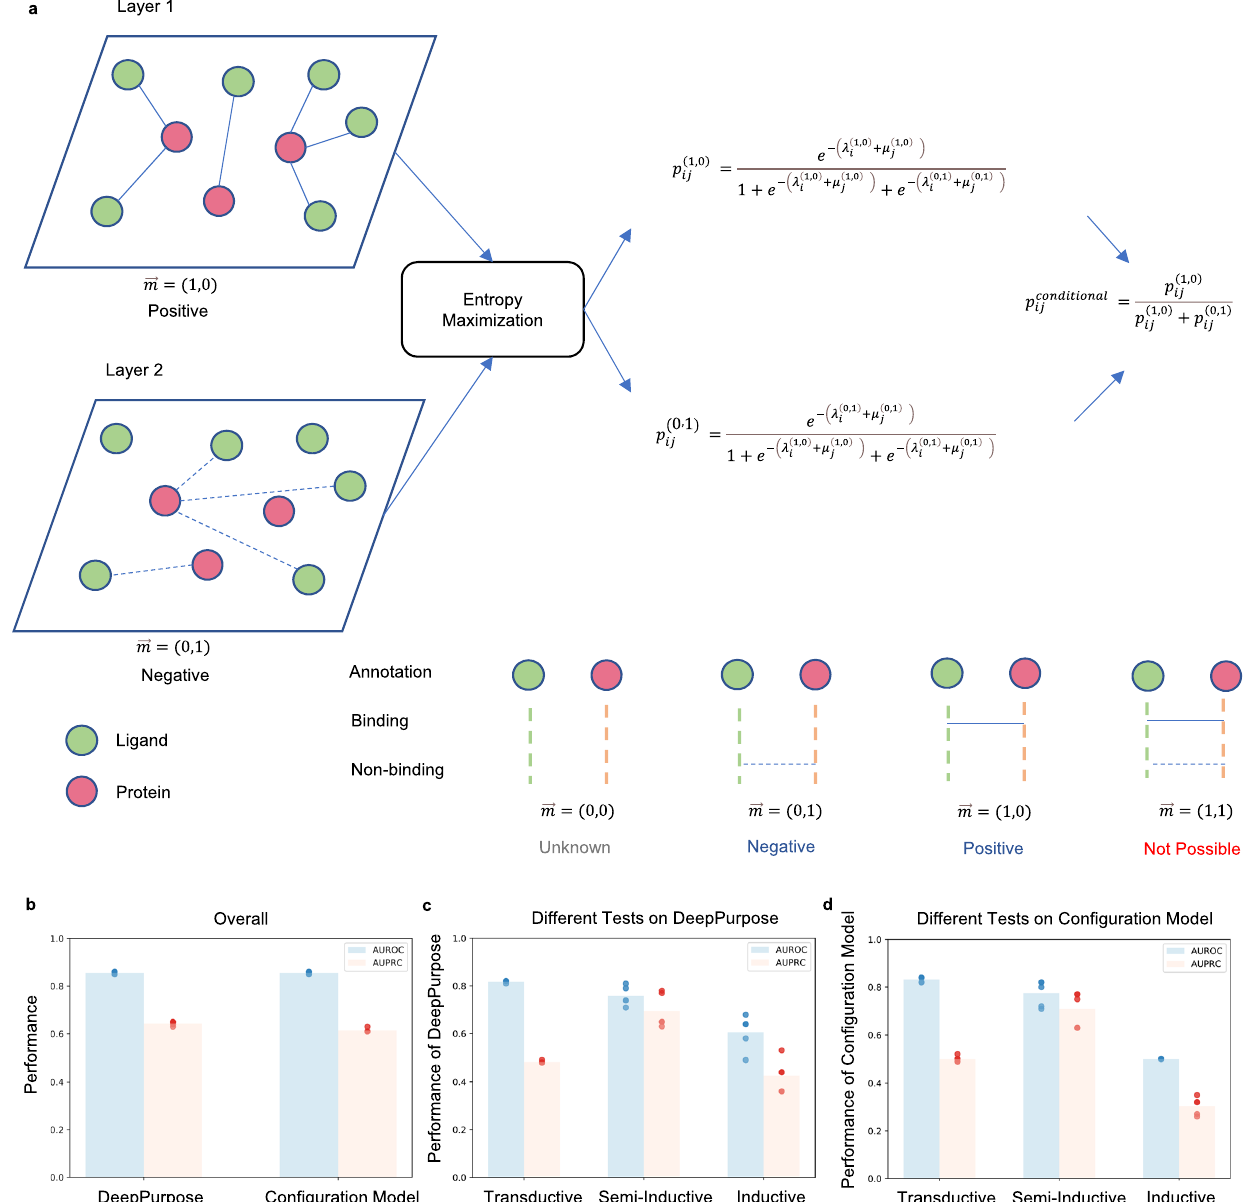
Fig. 3 | Comparing DeepPurpose and the duplex con fi guration model. a The duplexcon fi gurationmodelincludestwolayerscorrespondingtobindingandnon- binding annotations between proteins (pink nodes) and ligands (green nodes). Positive link (solid lines) and negative link (dashed lines) probabilities are deter- mined by entropy maximization (see Methods), and used to estimate the condi- tionalprobability in transductive (Equation(7)),semi-inductive (Equation (8)), and inductive (Equation (9)) scenarios. b – d The average performance of the